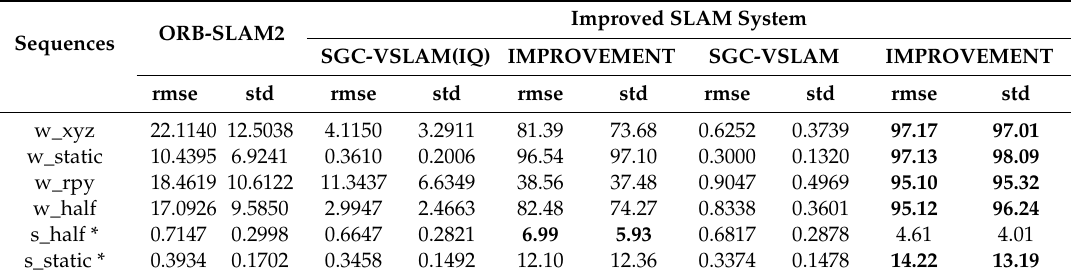
Table 3. Experimental results of the relative rotational trajectory